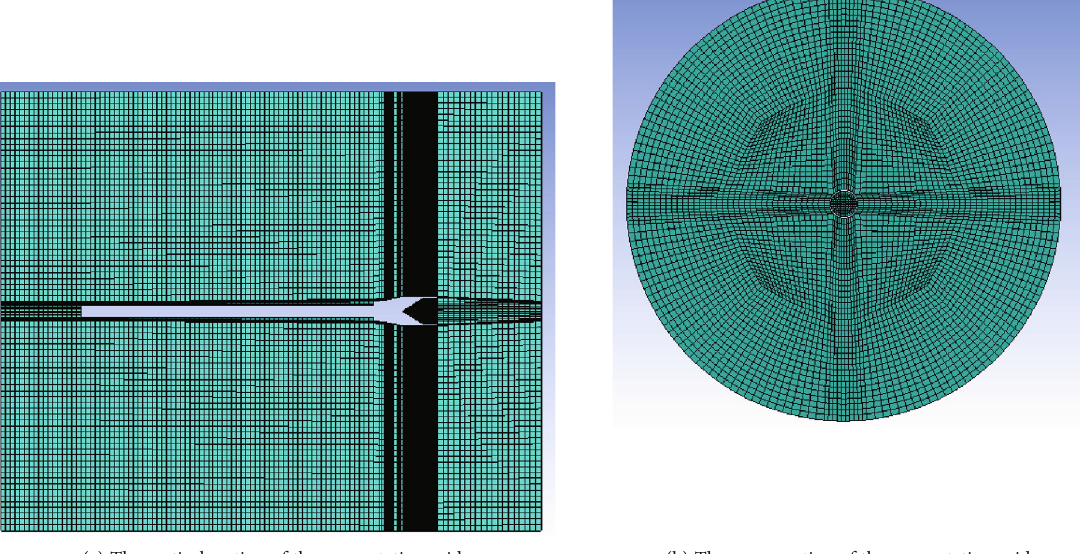
Figure 8: The section of out fl ow fi eld calculation